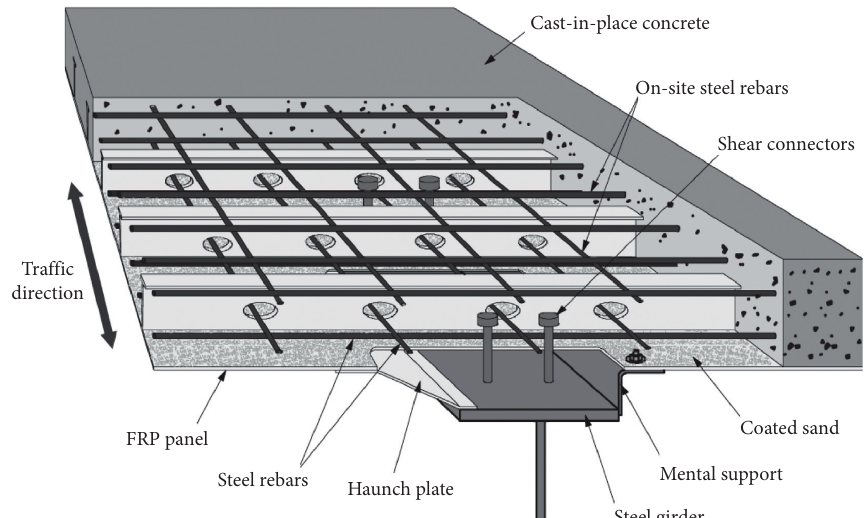
Figure 1: Schematic view of the hybrid deck studied by Japanese.